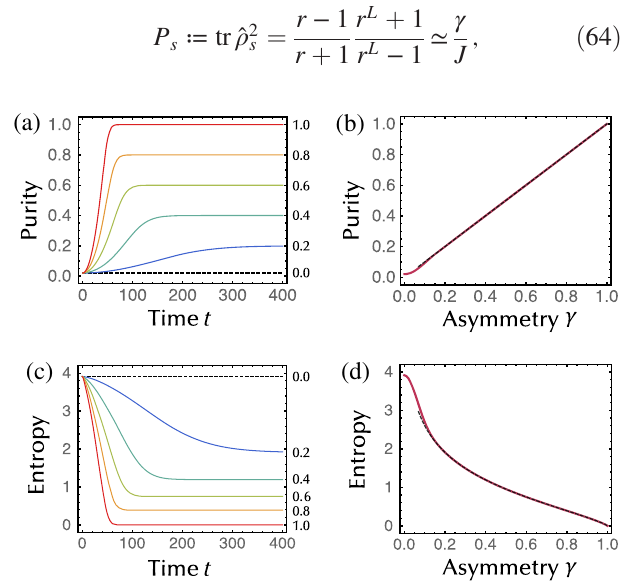
FIG. 15. Purification induced by the Liouvillian skin effect ( L ¼ 50 , J ¼ 1 . 0 ). The initial state is prepared as the completely mixed state ˆ ρ 0 ¼ 1 =L with the purity P 0 ¼ 1 =L and the von Neumann entropy S 0 ¼ log L . (a) Time evolution of the purity for γ ¼ 0 . 0 (black dashed curve), γ ¼ 0 . 2 (blue curve), γ ¼ 0 . 4 (green curve), γ ¼ 0 . 6 (light green curve), γ ¼ 0 . 8 (orange curve), and γ ¼ 1 . 0 (red curve). (b) Steady-state purity as a function of γ (red curve), consistent with the analytical result P ≃ γ =J (black dashed curve). (c) Time evolution of the von s Neumann entropy. (d) Steady-state von Neumann entropy as a function of γ (red curve), consistent with the analytical result S ≃ ð J þ γ = 2 γ Þ log ð J þ γ = 2 γ Þ − ð J − γ = 2 γ Þ log ð J − γ = 2 γ Þ (black s dashed